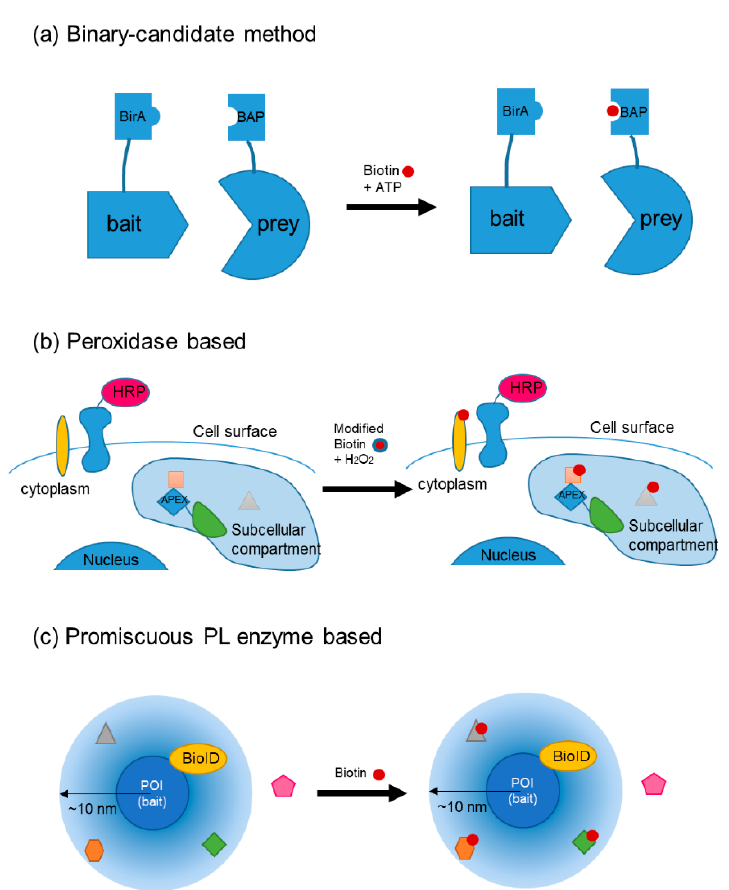
Figure 2. Three major categories of proximity labeling. Each category is illustrated by one or two representative enzyme systems. ( a ) Binary-candidate PL method using BirA and BAP attached to the bait and prey proteins, respectively. The reaction is induced by biotin and ATP; ( b ) Peroxidase based PL using Horseradish peroxidase (HRP)-based method on cell surface or APEX in a cellular compartment. The reaction is induced by modified biotin molecules and H 2 O 2 ; ( c ) Promiscuous PL enzyme illustrated by BioID, which has a working distance around 10 nm. This PL reaction is induced by biotin.